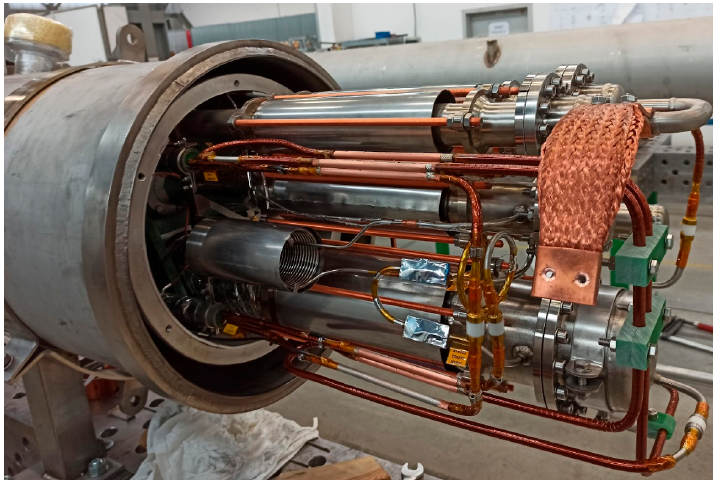
Figure 17. The module 1S42YP prepared for a SAT test.